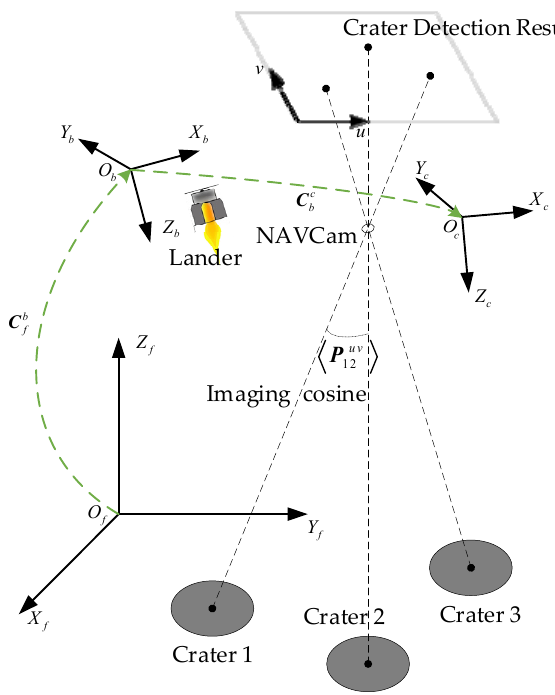
Figure 4. CDA-OPNAV model with imaging cosine.